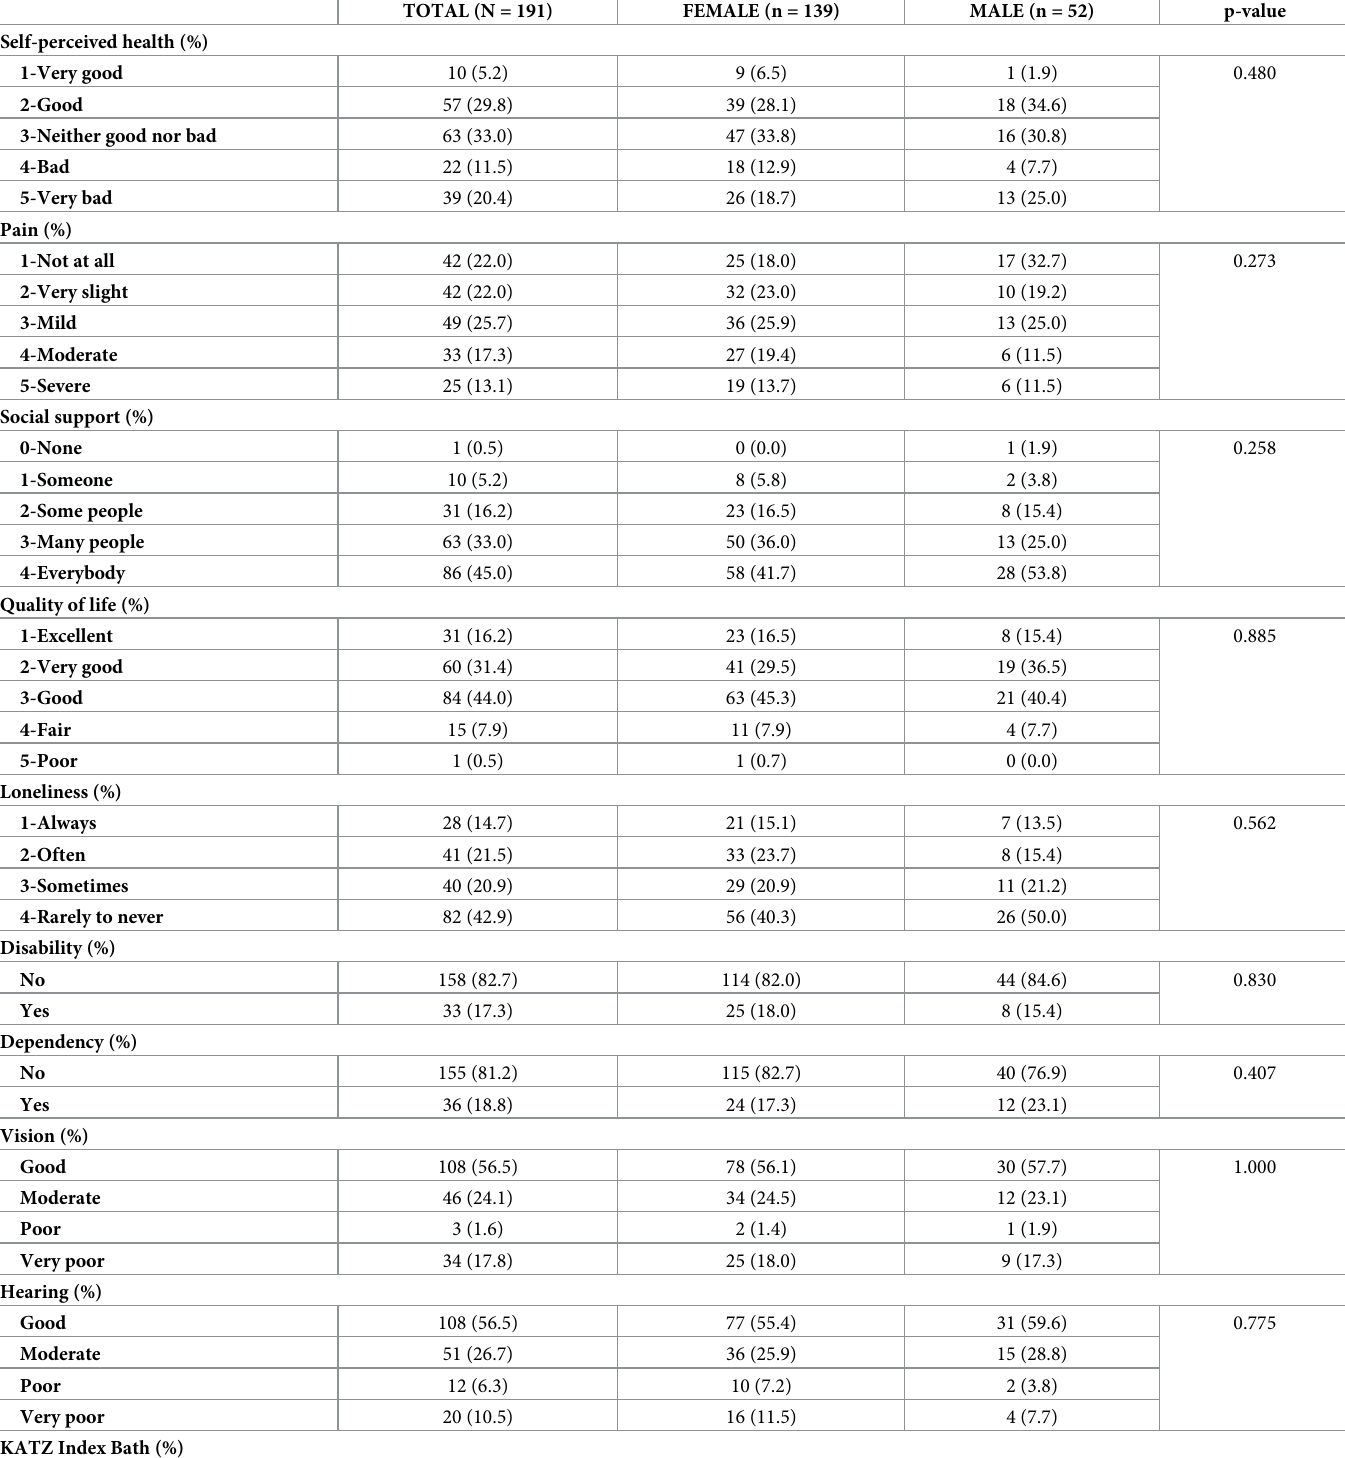
Table 4. Self-perceived health, quality of life and functionality of the